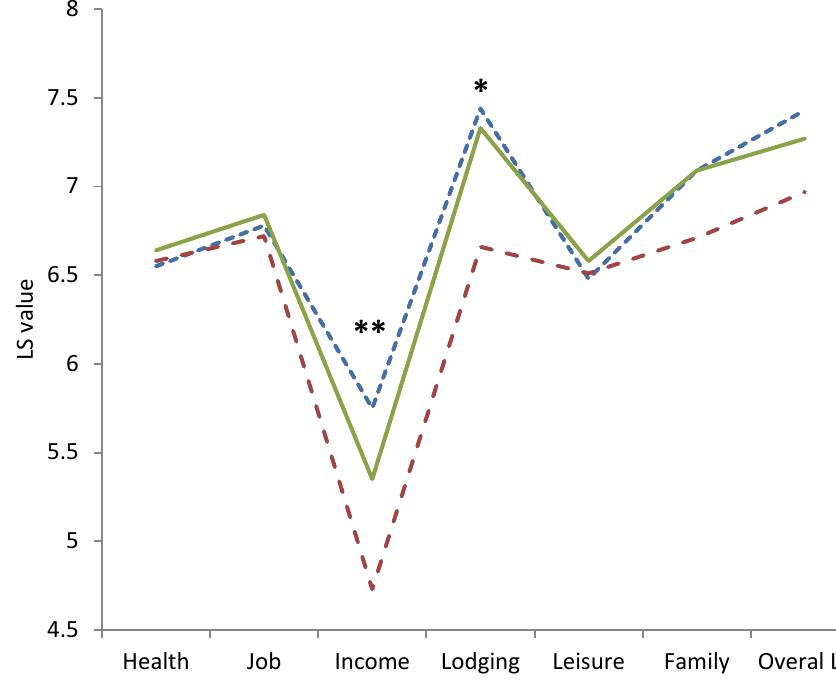
Figure 1. Life satisfaction values depending on commuting status: (BC) business-commuter (dotted blue line), (NC) non-commuters (solid green line), and (PC) private-commuters (dashed red line); * p < 0.01, ** ( p < 0.001) significant differences between all three groups .